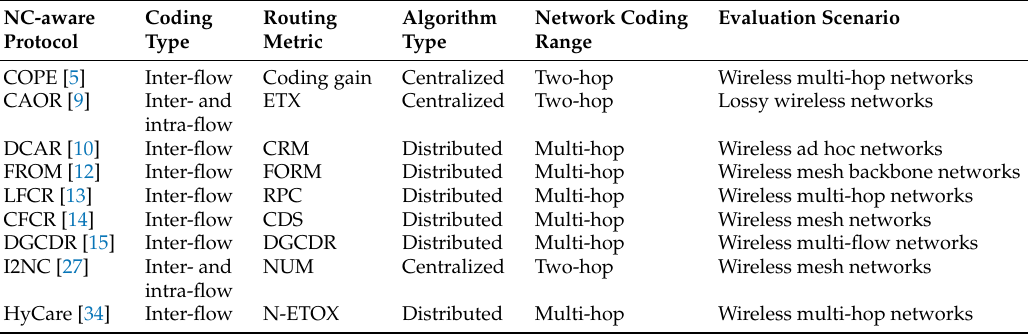
Table 1. Overview of the key NC-aware routing protocols. DCAR, distributed coding-aware routing; FROM, free-ride-oriented routing